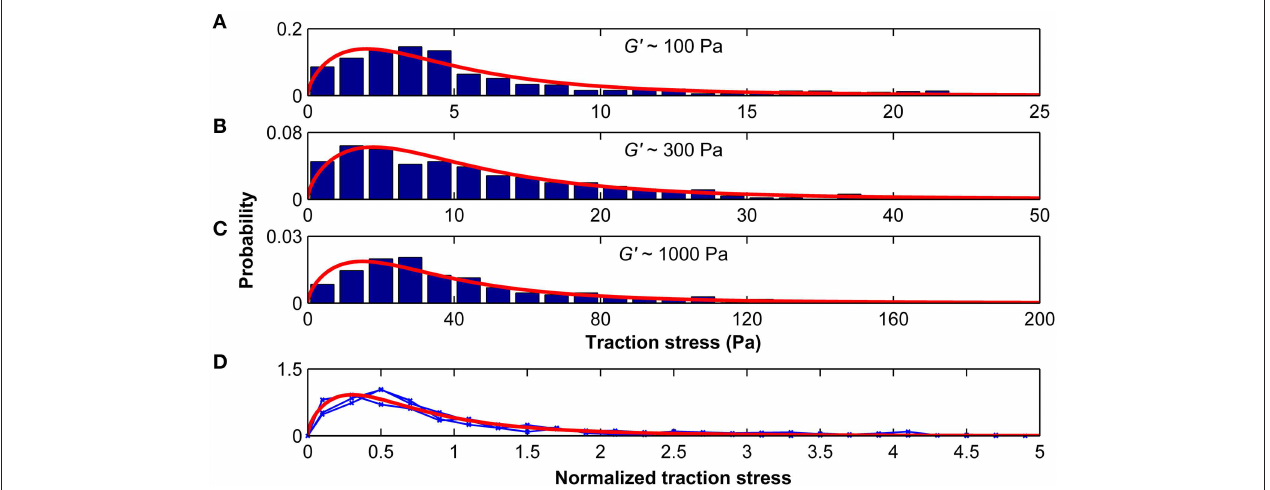
FIGURE 7 | Traction stresses are distributed according to a Burr distribution. Stress distributions for microglia growing on substrates of G ′ ∼ 100, ∼ 300, and ∼ 1000 Pa are shown in (A–C) , respectively. Red curves represent the best three-parameter Burr distribution fits. (D) The stress distributions were normalized by their standard deviation. Blue curves show the normalized stress distributions for G ′ ∼ 100, ∼ 300, and ∼ 1000 Pa, which were statistically similar ( p > 0 . 25 , Kruskal-Wallis ANOVA). The red curve shows the Burr distribution fit for all data